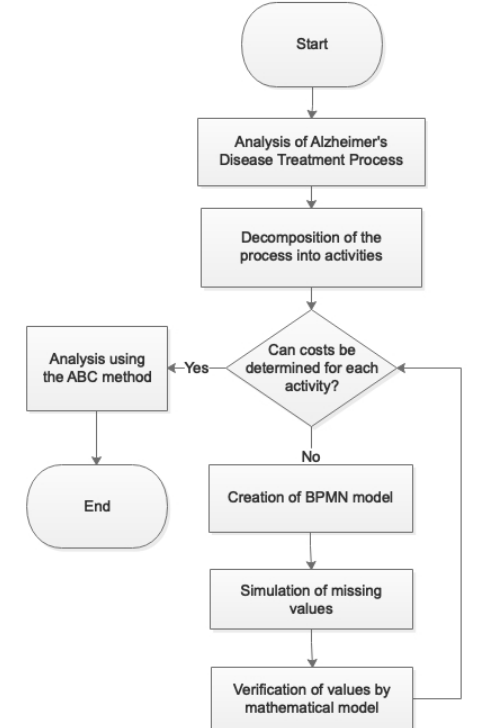
Figure 2. Research flowchart. ABC, Activity-Based